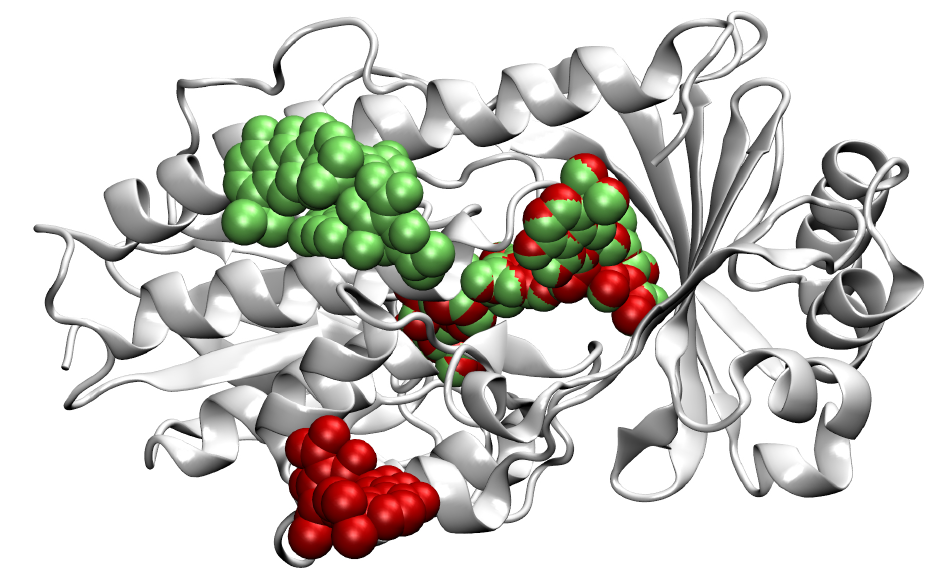
Figure 2. A representation of merging of ligands to the chain D of the PBD file 4a99 [24,25]. Ligands originally on the chain D are shown in green and ligands from the chain A are red. We see that the two chains have the right ligand in common and that the other two ligands originally had only one of them present. In this specific case, we kept the chain D with its original two ligands and added the lower ligand in red. For the representation, we use the VMD [26]